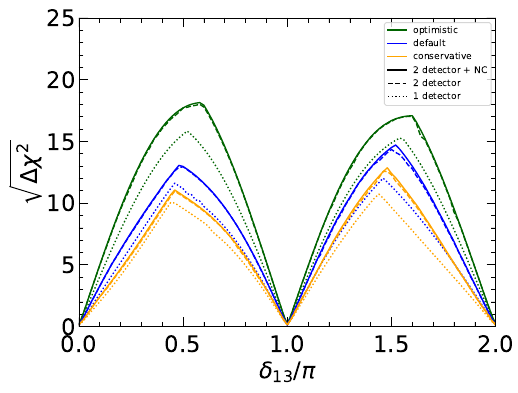
Figure 1 . The sensitivity to measure CP violation at ESS ν SB for different choices of systematic uncertainties and detector